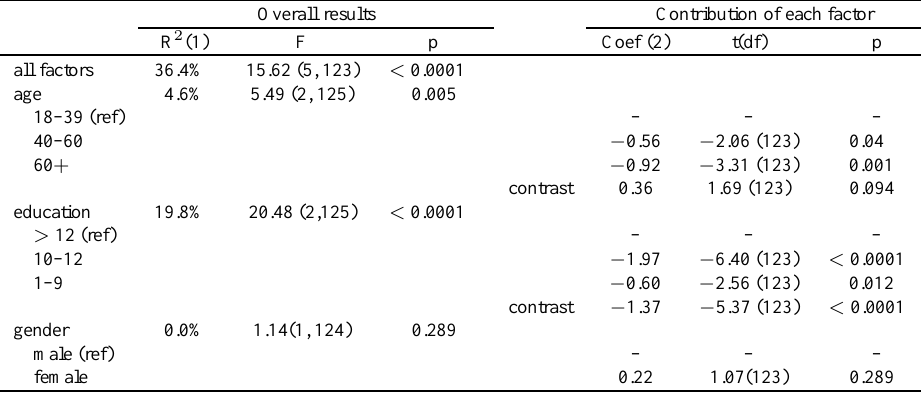
Table 3 Predictors of the oral expression